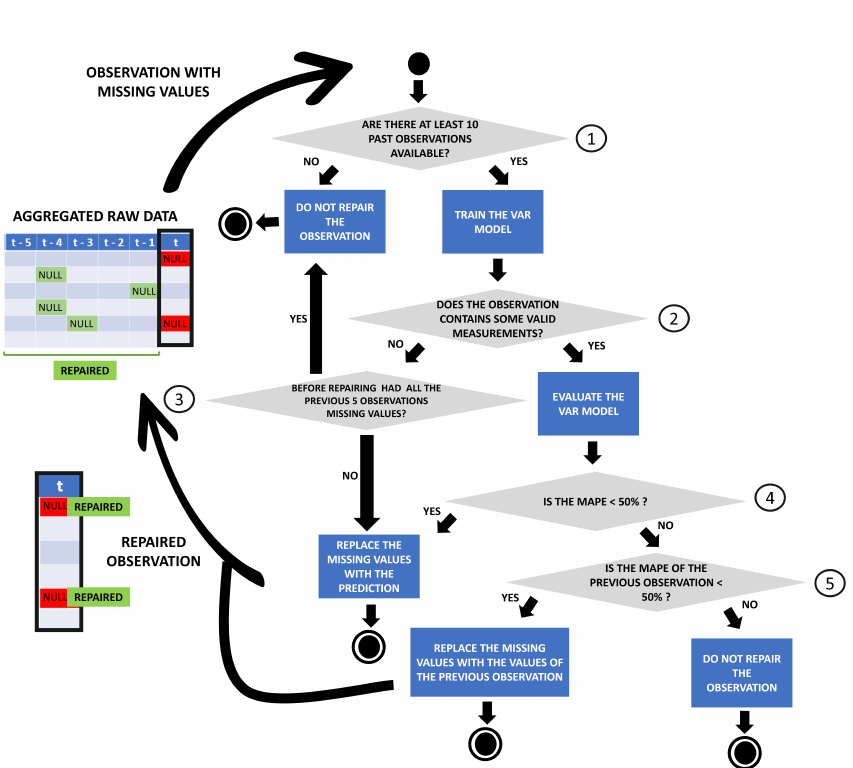
Figure 5. The repairing procedure applied on each raw observation with missing values and restarted when the sensor status